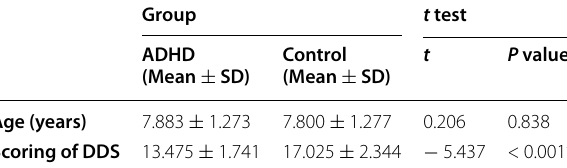
Table 2 Comparison of total age and DDS score mean between ADHD and control